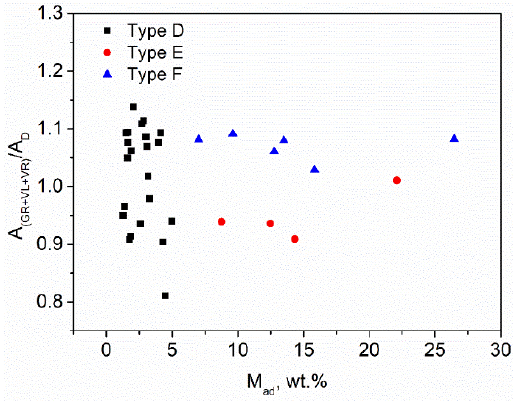
Figure 4. The correlation between M ad in parent coal and A (GR+VL+VR) /A D of its pyrolytic char. The chars of type D, E, and F were from coals with M ad < 5%, M ad > 5% and A ad < 10%, and M ad > 5% and A ad > 10%, respectively.